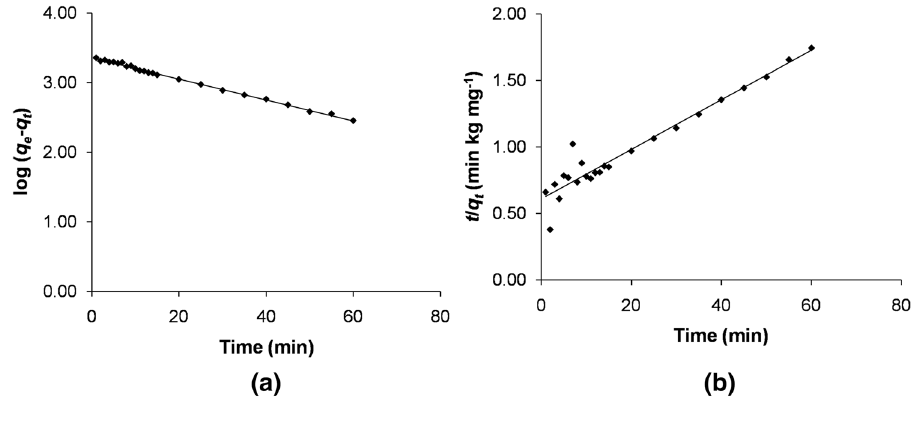
Fig. 6 Adsorption isotherm for removal of Ni(II) by the peel of Artocarpus nobilis fruit. a Langmuir adsorption iso- therm, b Freundlich adsorption isotherm